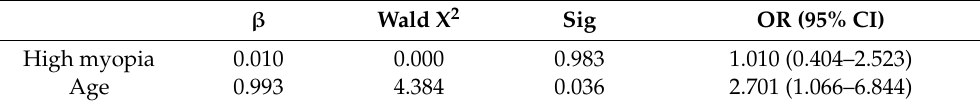
Table 3. Binary logistics regression analysis of high myopia and age for SRF absorption. β Wald X 2 Sig OR (95% CI) High myopia 0.010 0.000